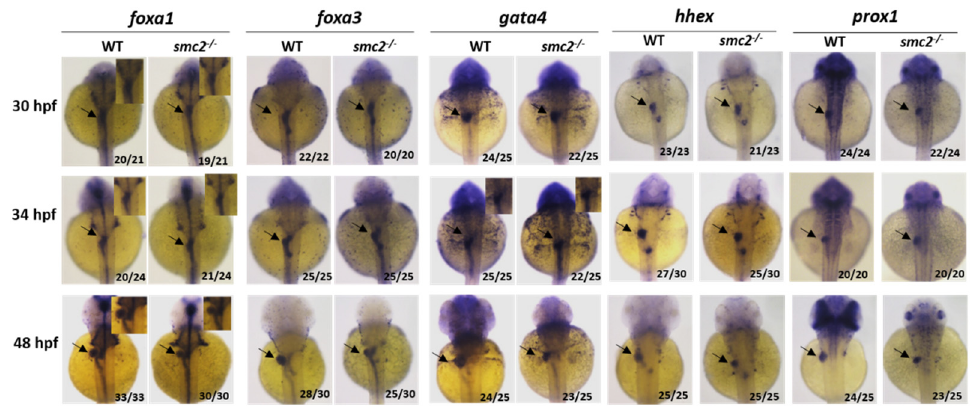
Figure 4 . SMC2 is required for liver expansion. WT and SMC2 − / − mutant embryos were analyzed with markers for liver specification and liver bud expansion at 30, 34 and 48 hpf. WISH probes used include pan-endodermal markers gata4 , foxa1 , foxa3 , and hepatic markers prox1 and hhex . Black arrowhead: liver.